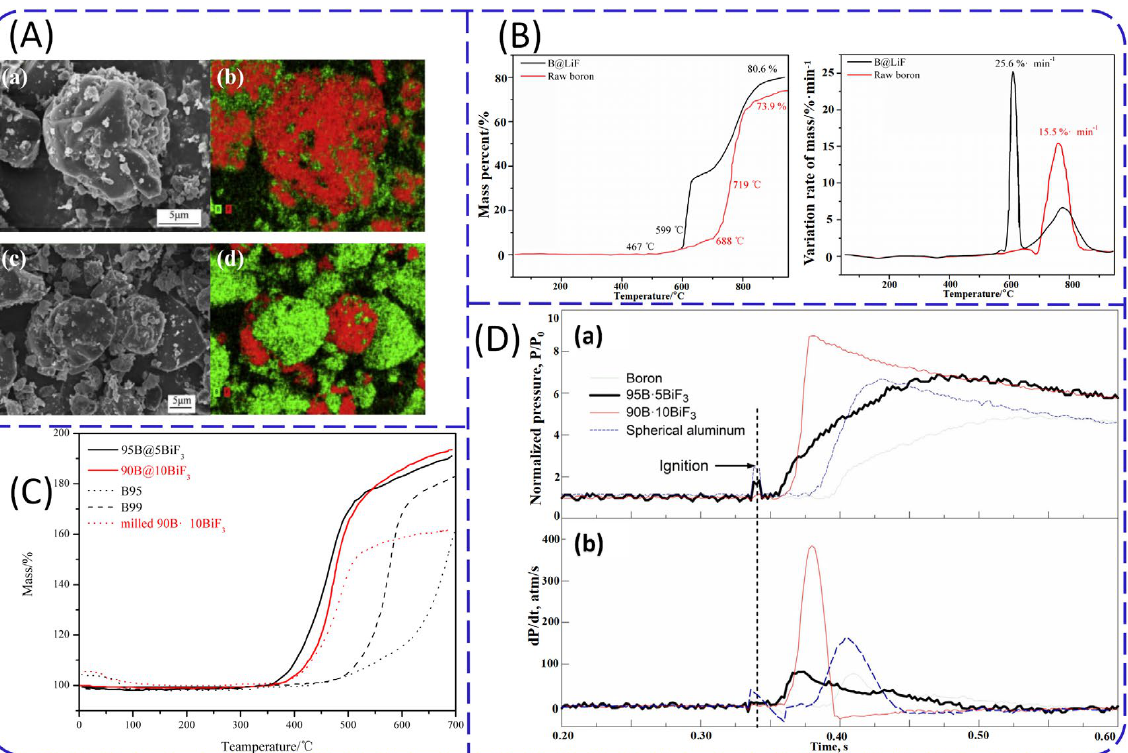
Figure 9. ( A ) SEM and elemental mapping images of ( a ) and ( b ) B@LiF; ( c ) and ( d ) B/LiF [90]; ( B ) TG - DTG curves of boron and B@LiF [91]; ( C ) TG curves of B@LiF, B, and milled B - BiF 3 [92]; ( D ) constant - volume explosion experiments of B, 90B@10BiF 3 , 95B@5BiF 3 , and spherical aluminum powder ( a ) normalized pressure and ( b ) pressure change rate curves [92].